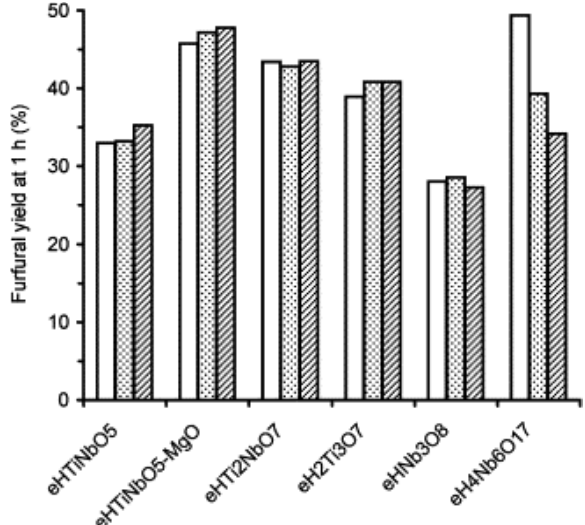
Figure 11. Furfural yield obtained in recycling runs (run 1—white bar, run 2—dots, run 3—hashed) over the exfoliated-aggregated nanosheet solid acid catalysts. Reproduced with permission from [29]; copyright (2006), Elsevier.